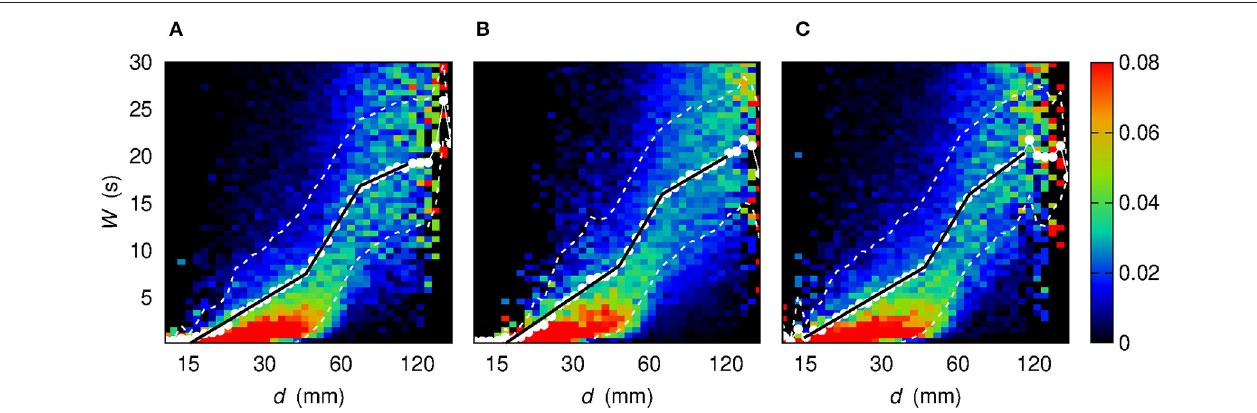
FIGURE 8 | Conditional sample probability distribution f ( W | log d ) (the d axis is in log scale) obtained by partitioning both the log d range and the W range in 50 bins. Each color map corresponds to a different sets of links. (A) Links for which both nodes are located in the left hemisphere. (B) Links for which the two nodes are located in opposite hemispheres. (C) Links for which both nodes are located in the right hemisphere. White dots show the average value W of W given log d . White dashed lines bound the 68% confidence region for W , namely the region within 1 σ from the average W . Black solid lines stem from a best-fit procedure to assess the piecewise-linear relationship between W and log d .